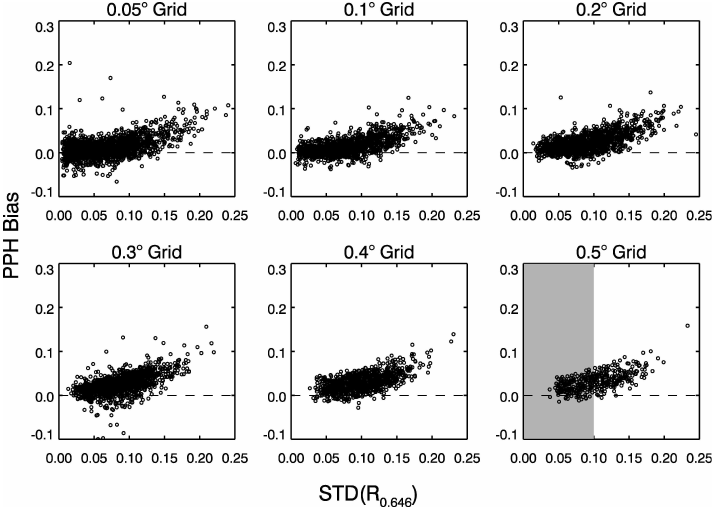
Fig. 4. Scatter plots of estimated PPH bias using MODIS one-month (July 2004) data for six grid sizes of 0.05 ◦ , 0.1 ◦ , 0.2 ◦ , 0.3 ◦ , 0.4 ◦ , and 0.5 ◦ vs. subgrid variability [STD( R 0 . 646